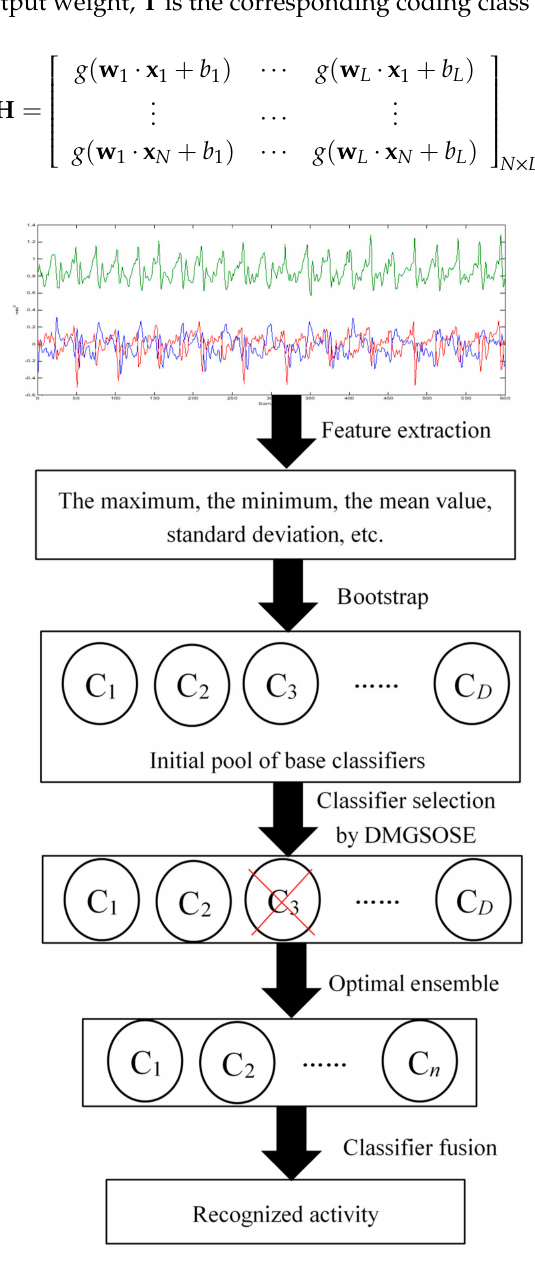
Figure 1. The framework of proposed selective ensemble-based HAR approach.